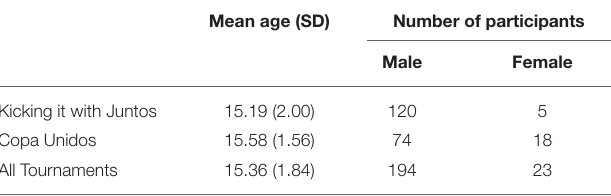
TABLE 1 | Participant demographics of Juntos